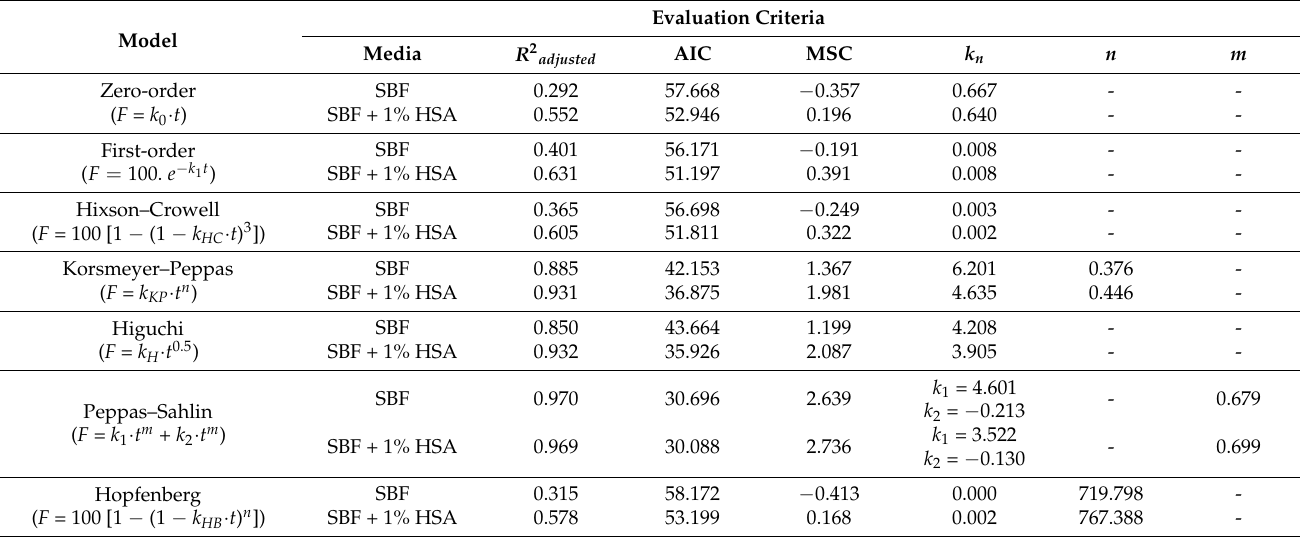
Table 4. Kinetic modelling on HHC release from HHCNPs by